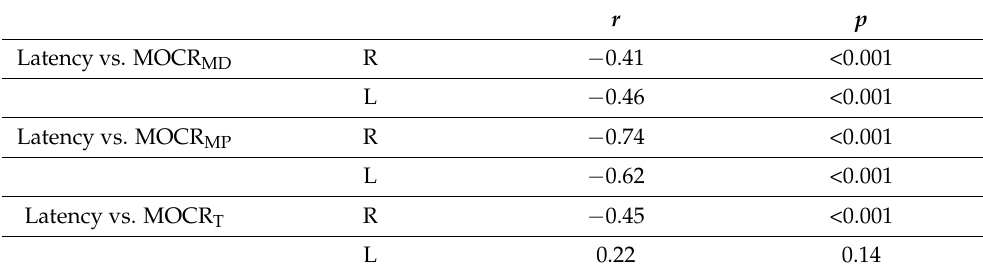
Table 5. Correlations between and TEOAE latency (at 1 kHz) and MOCR estimates. R, right; L, left.